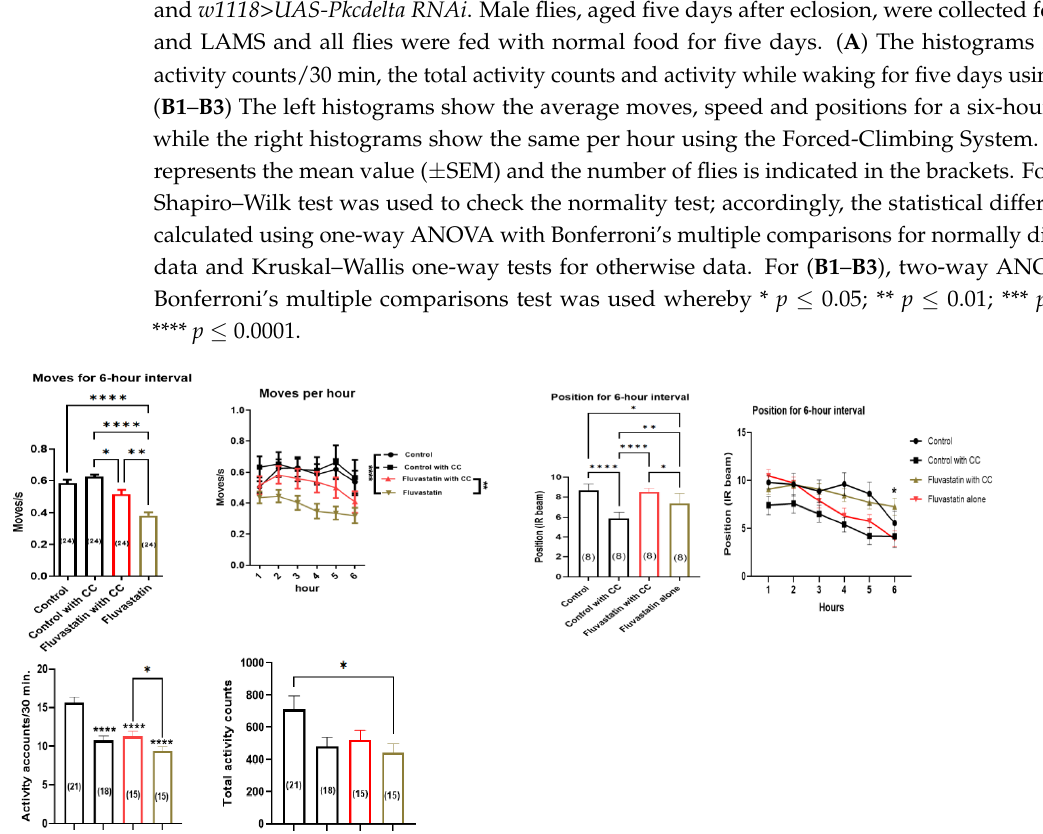
Figure 7. Pkcdelta disruption in the skeletal muscles improved general locomotion activity and climbing ability. Pkcdelta knockdown was carried out by using the Gal4-UAS system where the Pkcdelta RNAi knockdown group is EDTP-Gal4>UAS-Pkcdelta RNAi and controls are EDTP-Gal4>w1118 and w1118>UAS-Pkcdelta RNAi ). Male flies, aged five days after eclosion, were collected for DAMS